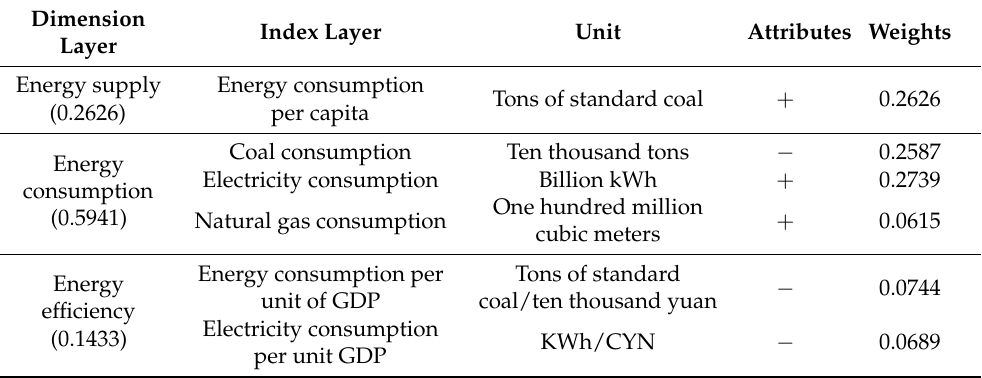
Table 2. Comprehensive evaluation index system for energy